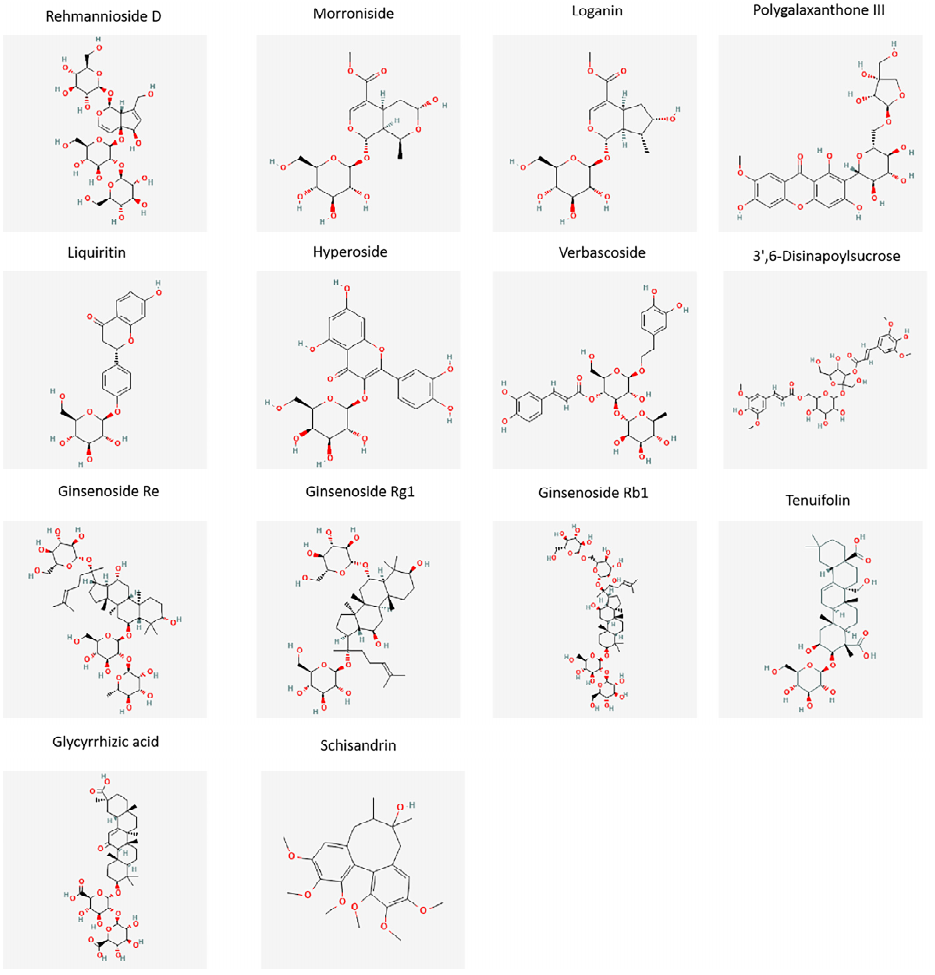
Figure 1. Structure information of the fourteen compounds analyzed in the GYJ samples.